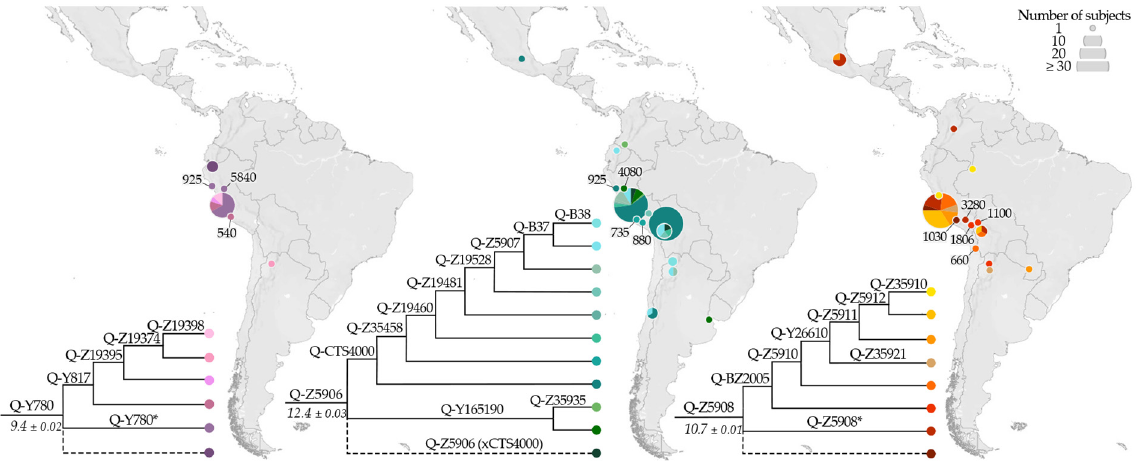
Figure 8. Geographical distribution of Q-Y780, Q-Z5906, and Q-Z5908 (ISOGG nomenclature: Q1b1a1a1j, Q1b1a1a1h, and Q1b1a1a1i, respectively—http://www.isogg.org/tree/, accessed on 19 January 2022) and their main sub-lineages. Ancient individuals are indicated with their median calibrated age (cal BP, see Table S1 for details). Dashed lines indicate samples less well defined (missing positions of informative downstream markers). In the phylogeny, the estimated ages of the nodes ( ± StDev) are reported in kya. (*) identifies samples negative for the markers of all derived